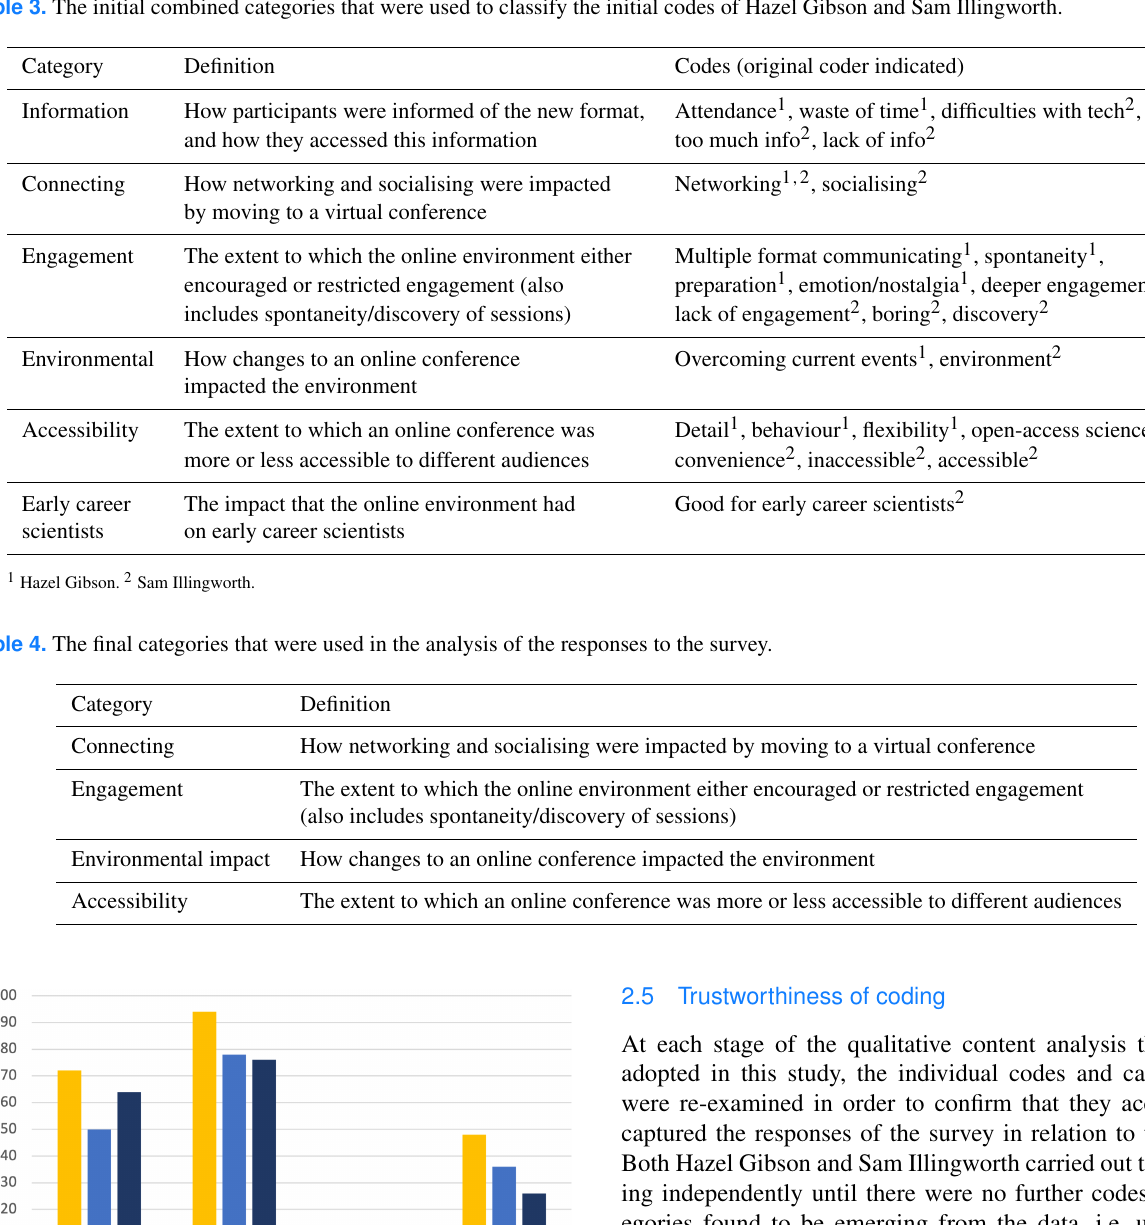
Table 3. The initial combined categories that were used to classify the initial codes of Hazel Gibson and Sam Illingworth.